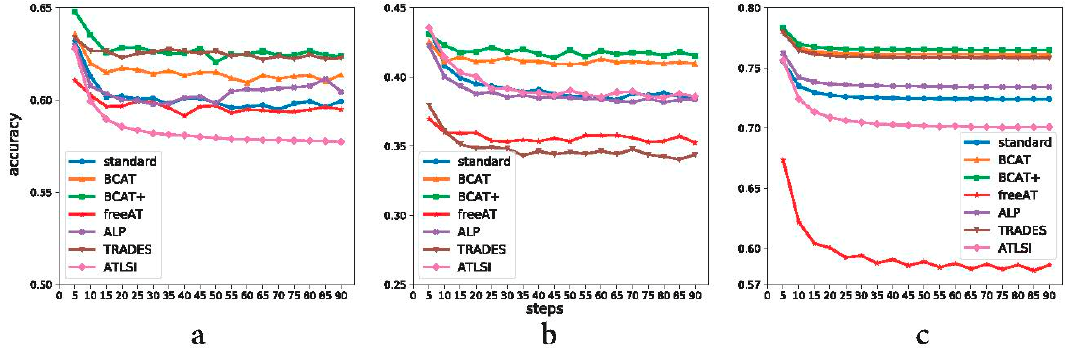
Figure 11. Robustness generalization curves of different defense methods under different attack steps on CIFAR-10, CIFAR-100, and SVHN. ResNet34, WRN34–5, and ResNet18 are used for CIFAR-10, CIFAR-100, and SVHN, respectively. ( a ) CIFAR-10. ( b ) CIFAR-100. ( c ) SVHN.